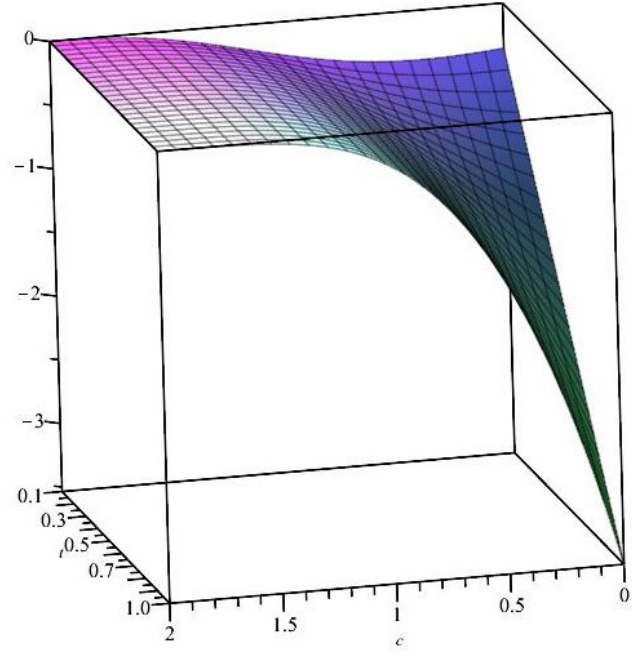
Figure 6. The variation of V { c } w.r.t. c and θ 2 : = t